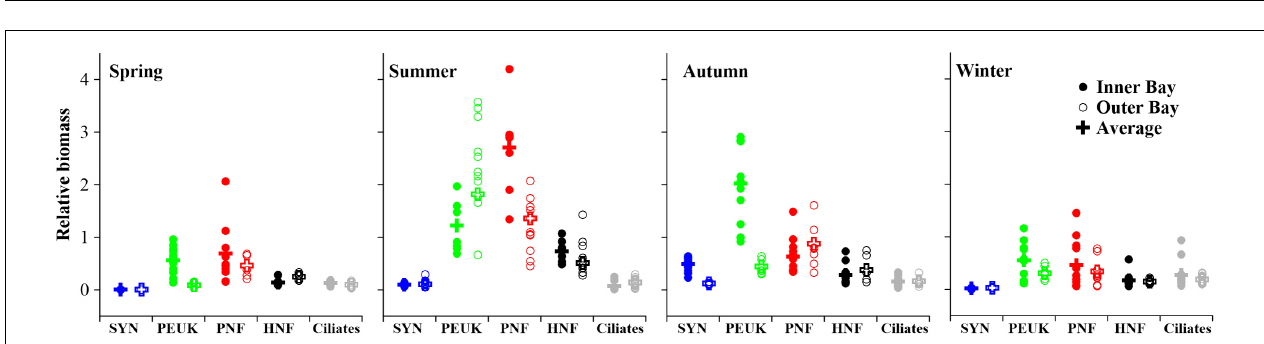
FIGURE 8 | Cluster analysis of stations according to (A) environmental conditions; (B) microbial food web component biomasses; (C) tintinnid abundances. • : Outer Bay cluster stations; +: Inner Bay cluster stations; ◦ : stations neither belonging to Inner Bay nor Outer Bay clusters. The solid lines show the dividing position between Inner Bay and Outer Bay in Figure 9 mainly according to (A) in the four seasons.